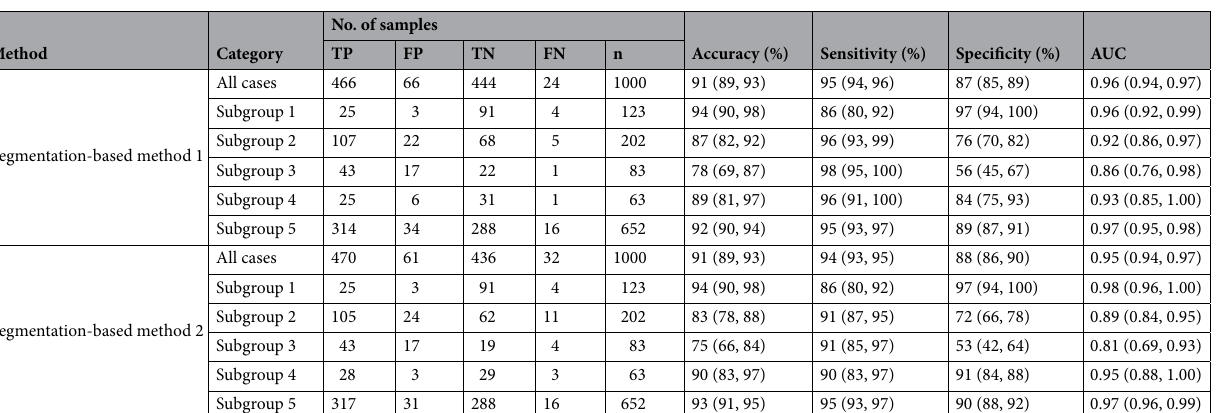
Table 2. Diagnostic performance of detection of cardiomegaly. Data in parentheses indicate 95% confidence intervals. TP true positive, FN false negative, TN true negative, FN false negative, AUC area under the receiver operating characteristic